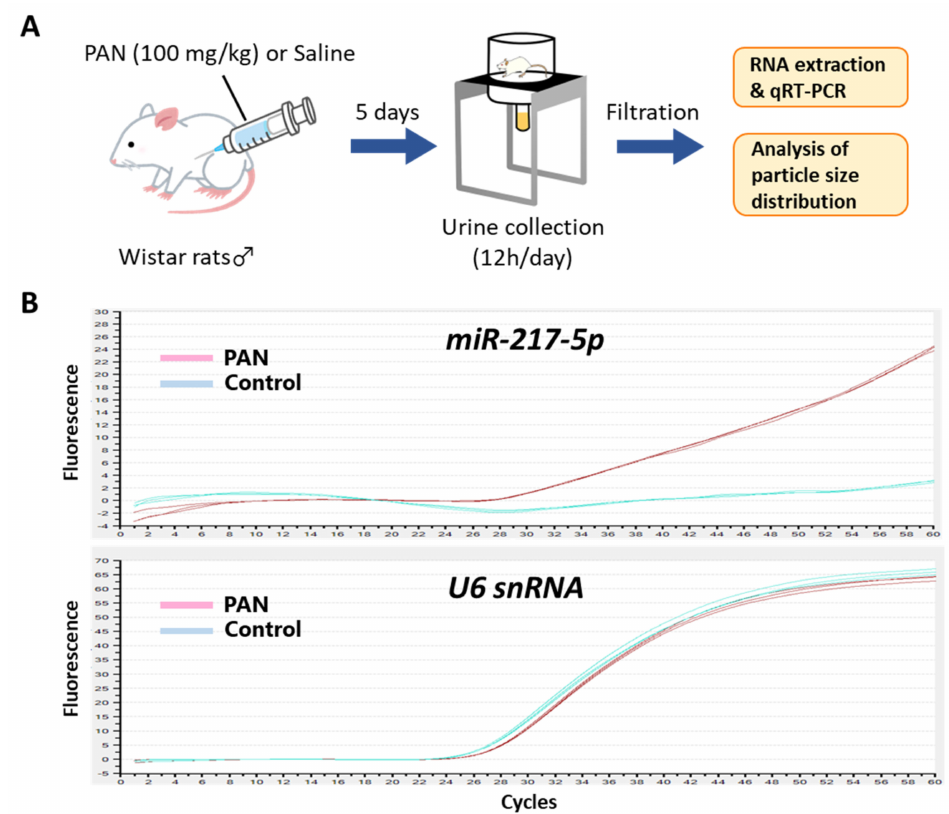
Figure 7. Detection of miR-217-5p in urine from PAN-administrated rats. ( A ) Schematic illustration of the experimental procedure. Seven-week-old male Wistar rats were administrated with 100 mg/kg PAN or saline. ( B ) Amplification plots of qRT–PCR for the detection of miR-217-5p and U6 snRNA in urine from the PAN- or saline-administrated rats. Urine samples collected at day 5 following PAN/saline administration were used for the